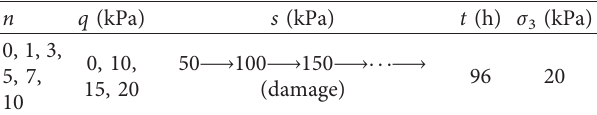
Table 5: Testing